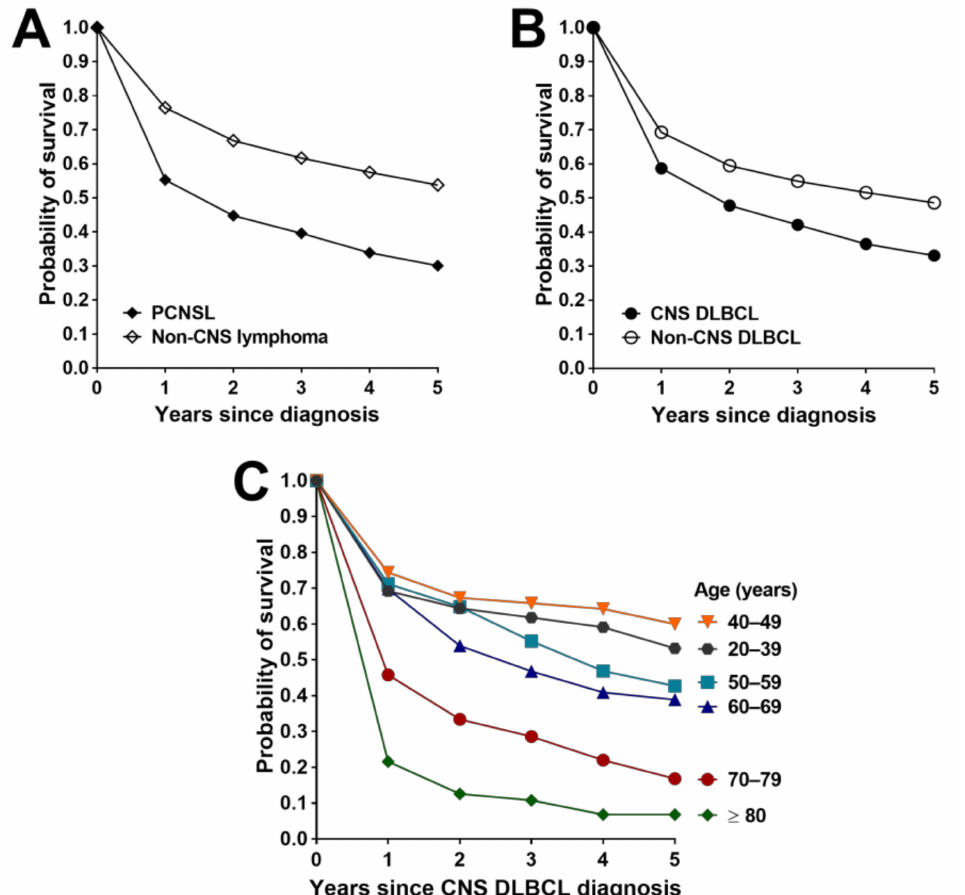
Figure 2. Probability of survival for up to 5 years in Australian adults with ( A ) primary central nervous system lymphoma (PCNSL) and non-CNS lymphoma; ( B ) diffuse large B-cell lymphoma (DLBCL) within the CNS and non-CNS compartments; ( C ) CNS DLBCL presented by age group at